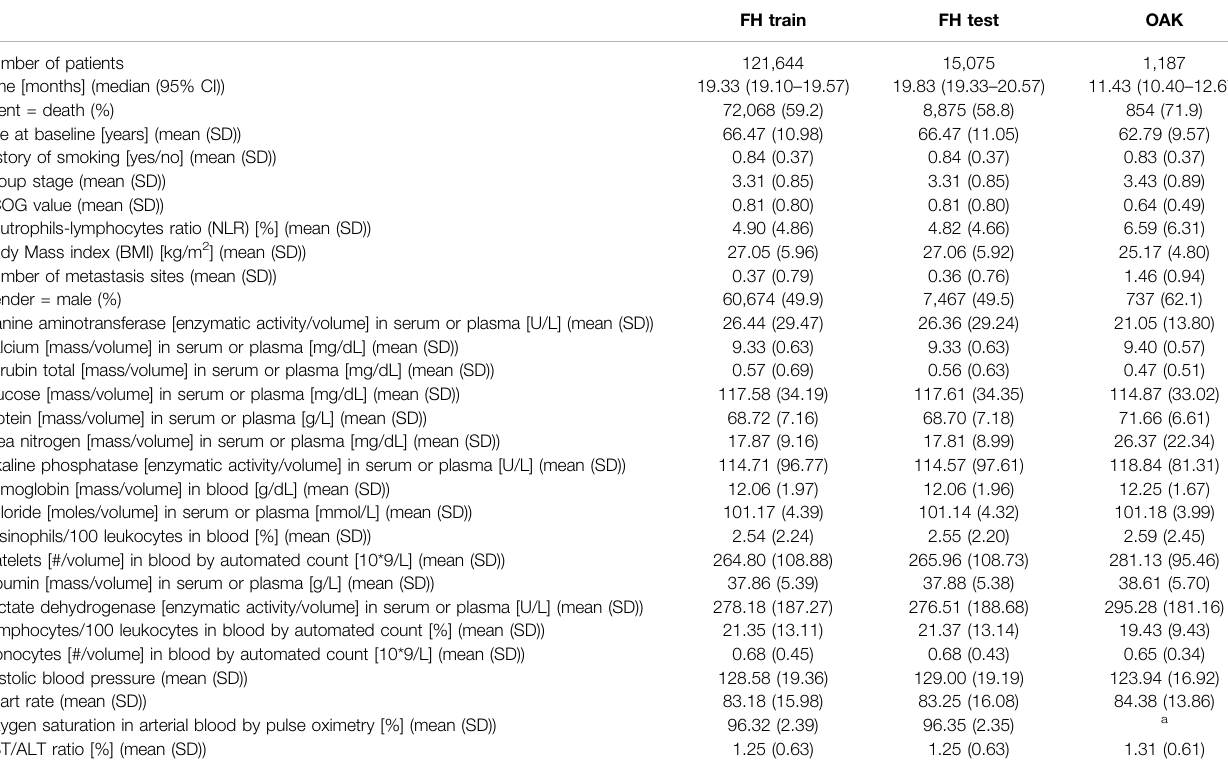
TABLE 2 | Summary statistics of the